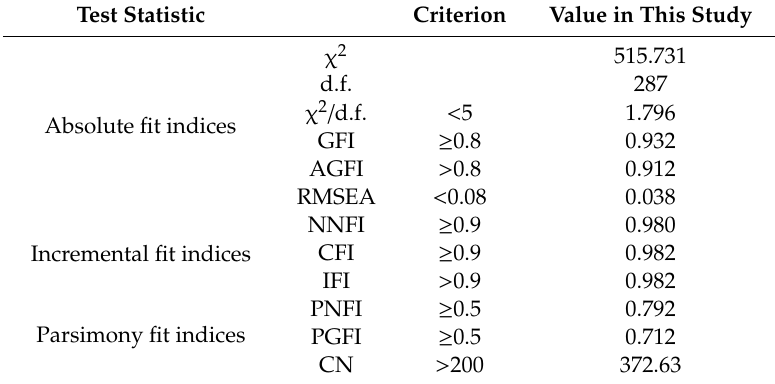
Table 4. Goodness-of-fit indices of structural equation model.